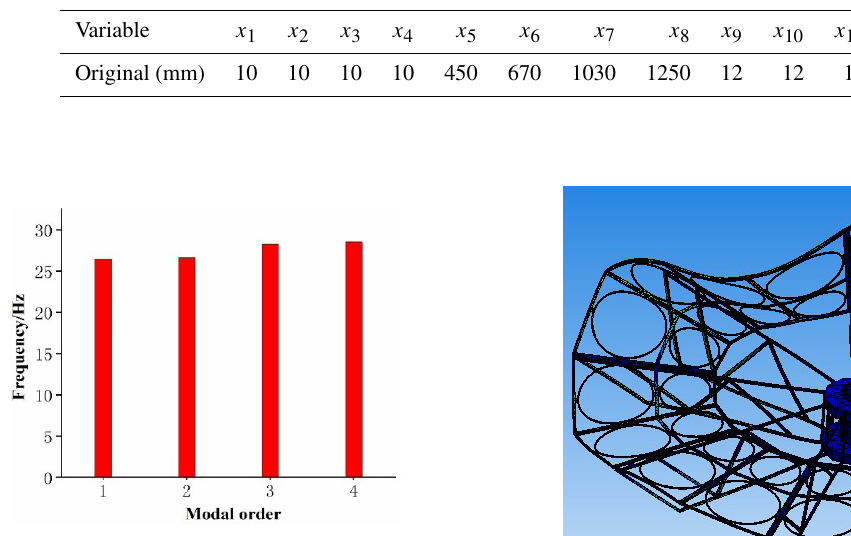
Figure 6. Schematic of the equivalent structure of thin-film diffraction imaging system after gridding. Table 2. Initial structure parameters of the thin-film diffraction imaging system.